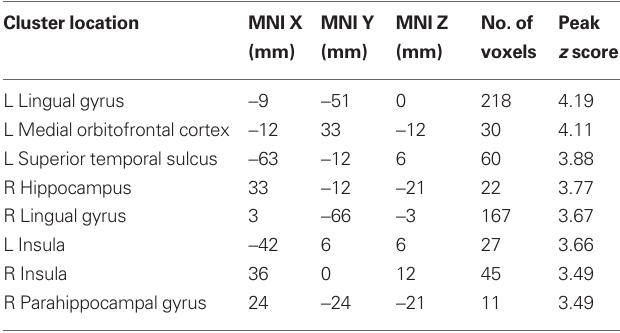
Figure 4 | BOLD responses to stock information. (A) Activation in ventral striatum reflecting subjective preference for the stock mean (peak at 9, 18, − 9; z = 4.2; p < 0.005). (B) Parameter estimates for the two groups. The left hand side of the chart displays the parameter estimates from the low mean-preferring group whereas the right shows the high mean-preferring group. (C) Activation in ventral striatum corresponding to stock variance (peak at 9, 12, − 3; z = 3.2; p < 0.05). (D) Parameter estimates for the high–low variance contrast. Table 2 | Locations of significant activation clusters for the value- preference contrast in a whole-brain analysis (Figure